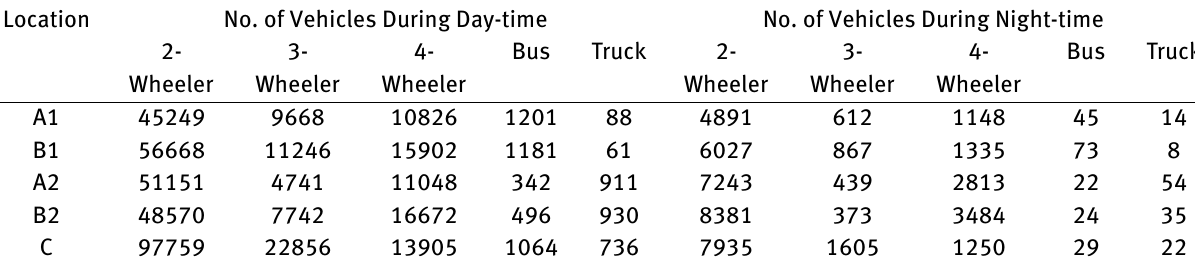
Table 2: Traflc volume (West Zone)